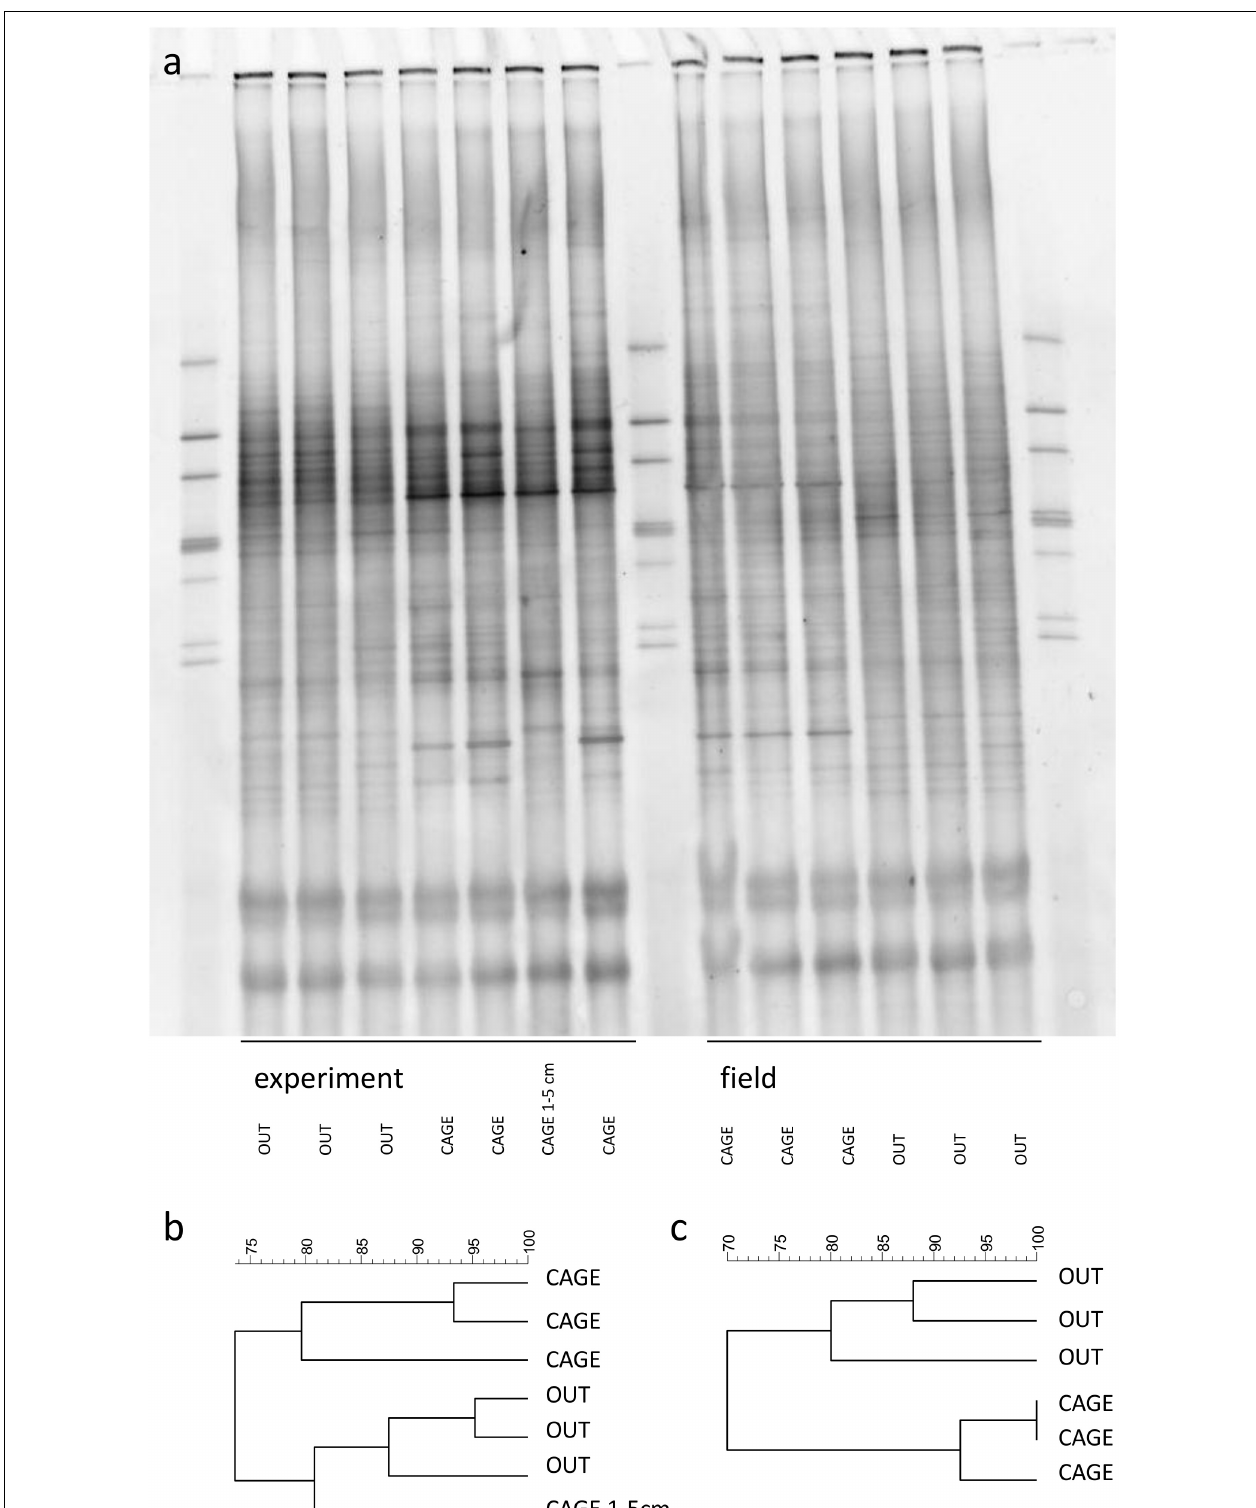
FIGURE 5 | The DGGE gel of the sediment bacterial community (a) . Samples were collected on top of the sediment prior to (field) and after 5 days incubation in the thermostatic chamber (experiment). An additional sample of lower sediment layer (1–5 cm) was collected at the end of the experiment. The dendrograms represent the similarity of experimental (b) and field (c) bacterial community (Dice (Tol 1.0%–1.0%)(H > 0.0% S > 0.0%)[0.0%–100.0%]).